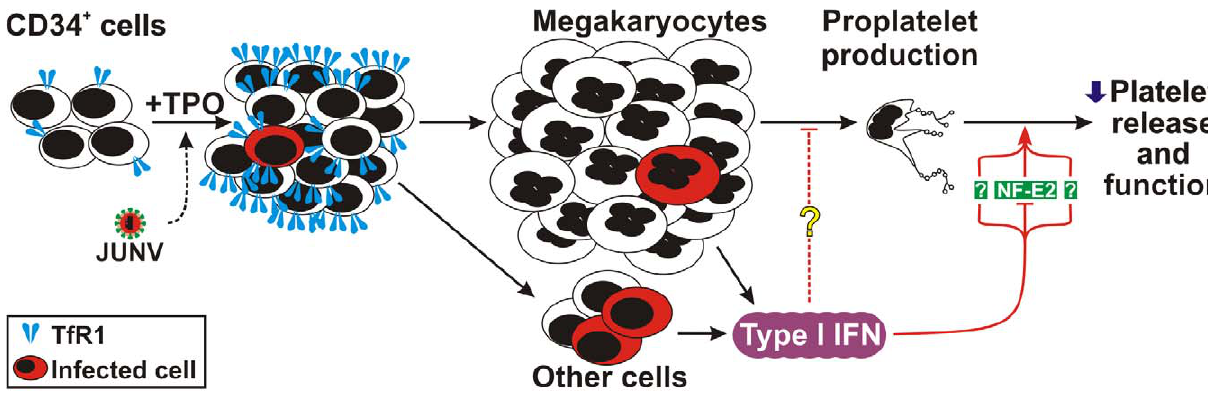
Figure 9. Model of JUNV infection of CD34 + cells stimulated with TPO. JUNV induces an increase in the expression of TfR1. A very low proportion of megakaryocytes are infected by JUNV, but the infection triggers type I IFN which impairs proplatelet production, platelet release and platelet function. The concomitant down-regulation of NF-E2 in the megakaryocytic population may be involved in this effect.